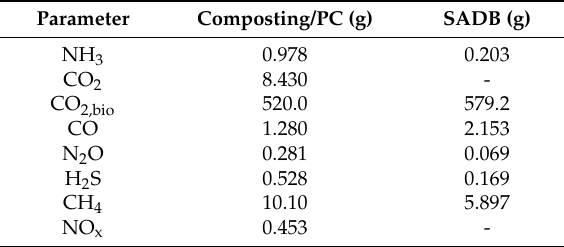
Table 1. Direct emissions in air for composting and post-composting (PC) and for solid anaerobic